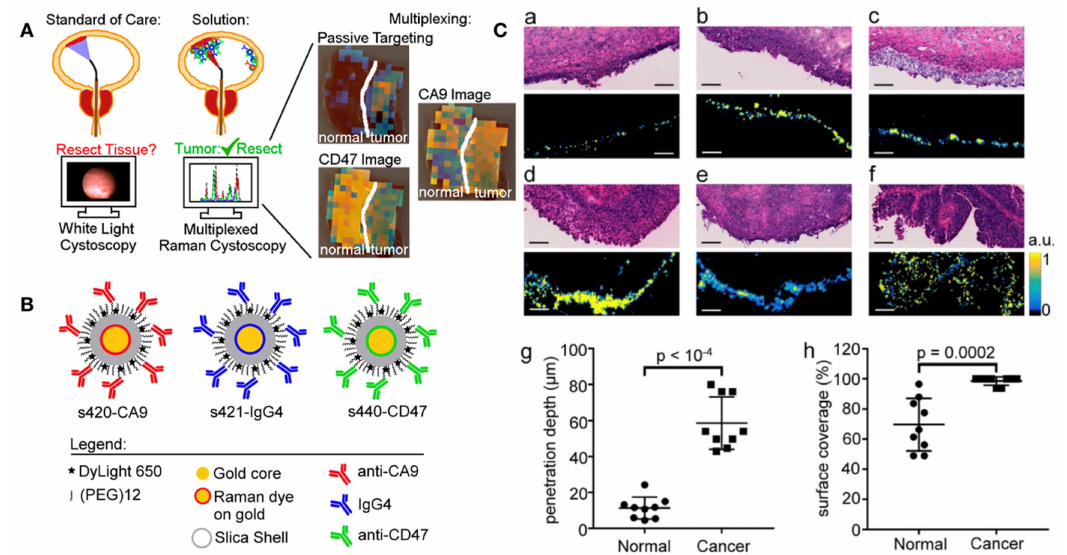
Figure 4. Surface-enhanced Raman nanoparticle could simultaneously carry a variety of antibodies which enabled the multiplexed detection of multiple molecular targets. ( A ) Surface-enhanced Raman nanoparticle endoscope system with multiplexed molecular imaging of CD47 and CA9 enabled to classification of bladder tissue as normal or cancerous. Multiplexed molecular imaging of CD47 and Carbonic Anhydrase 9 tumor proteins. ( B ) The antibodies bound different color surface-enhanced Raman scattering (SERS) nanoparticles. The blue IgG4 nanoparticle is used as a negative experimental control for the active binding of CA9- and CD47-targeted SERS nanoparticles. ( C ) H&E stains ( top ) and s421-IgG4 Raman images ( bottom ) of normal bladder tissue ( a – c ) and different grade of bladder cancer tissue ( d – f ). ( g – h ): Passively targeted nanoparticles penetrated 5-fold deeper and bound to tumor tissue at 3.3-fold higher concentrations in cancer compared to normal bladder urothelium. Reprinted with permission from ref. [77]. Copyright 2018,